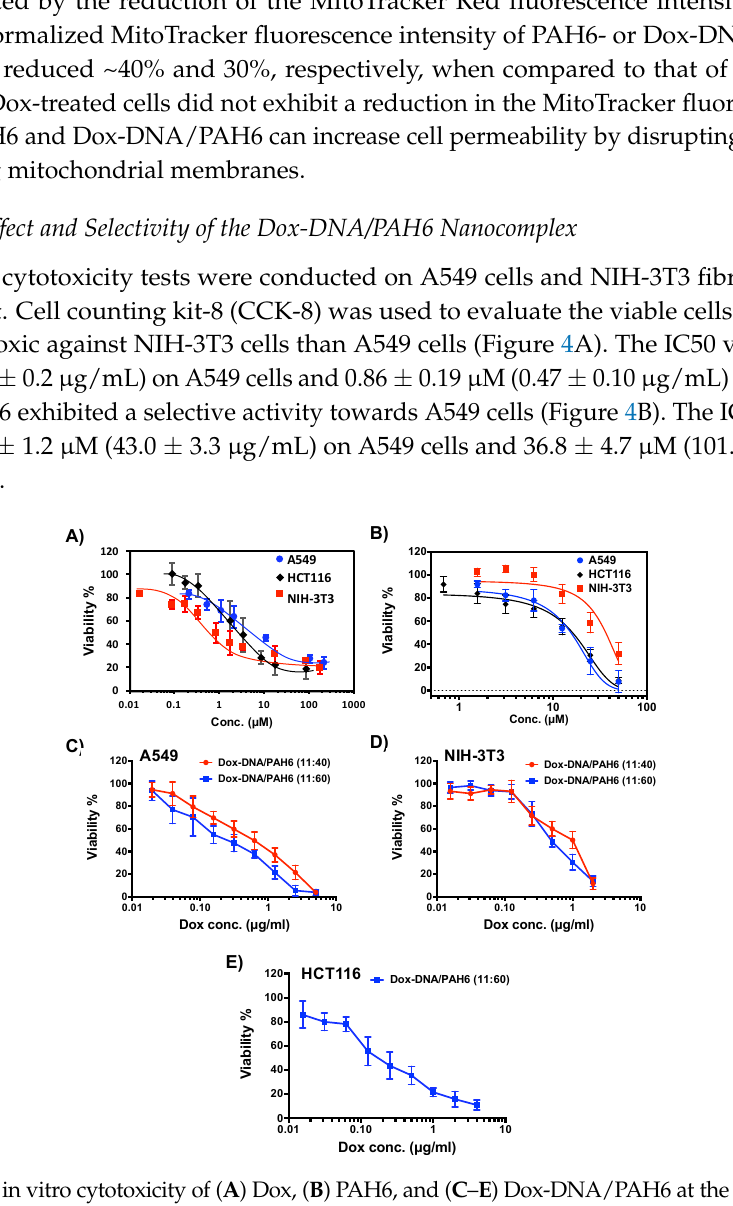
Figure 4. The in vitro cytotoxicity of ( A ) Dox, ( B ) PAH6, and ( C – E ) Dox-DNA/PAH6 at the mass ratios of Dox-DNA to PAH6 of 11:40 and 11:60 on A549, HCT116, or NIH-3T3 cells. Error bars represent SD ( n =